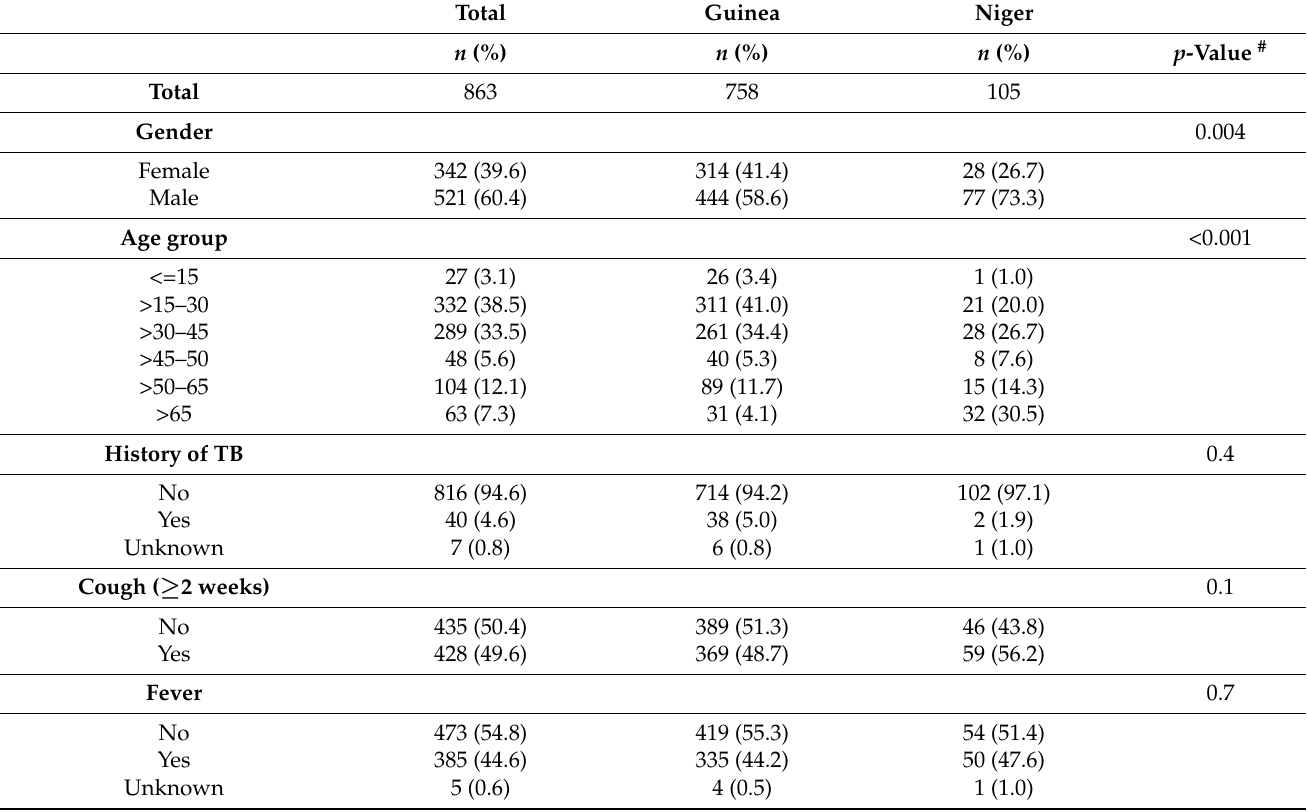
Table 2. Socio-demographic and clinical characteristics of individuals screened for TB/COVID-19 in Guinea and Niger.